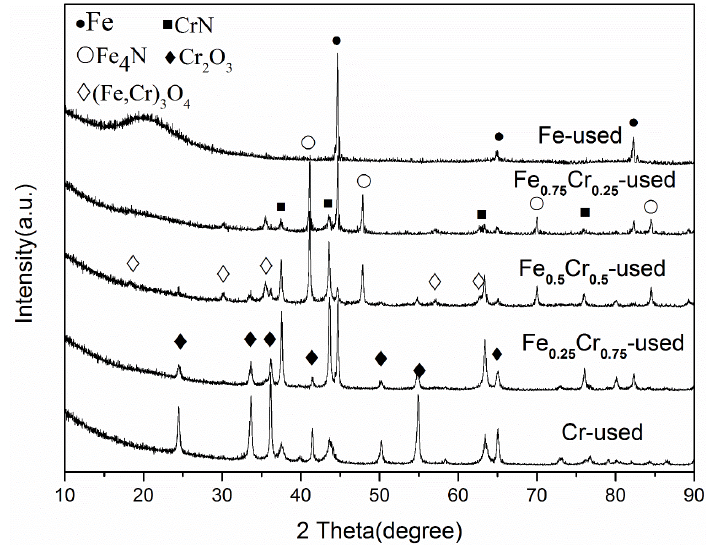
Figure 5. XRD patterns of used FeCrO x catalysts after NH 3 decomposition reaction.